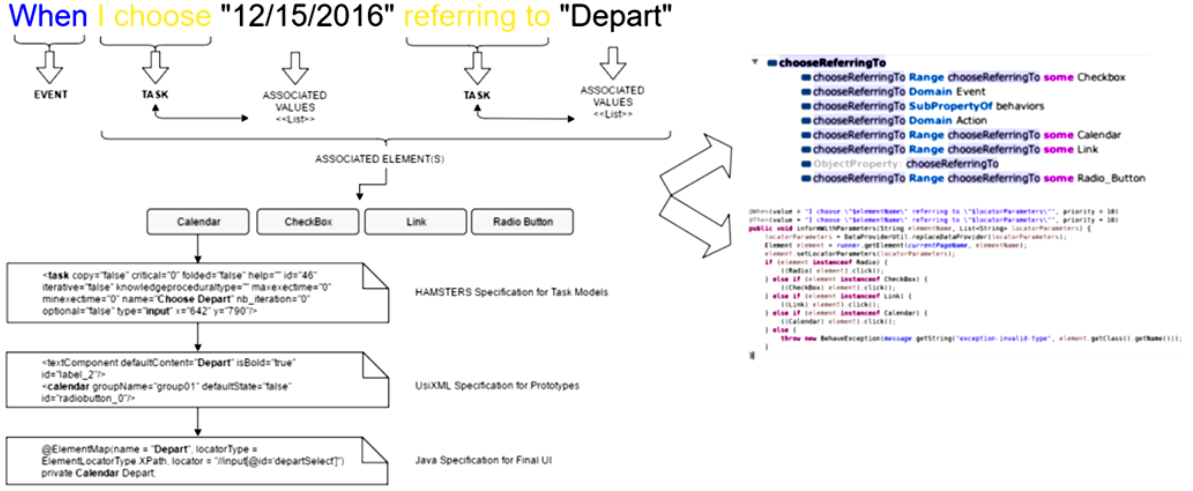
Figure 13. Identifying behaviors through multiple